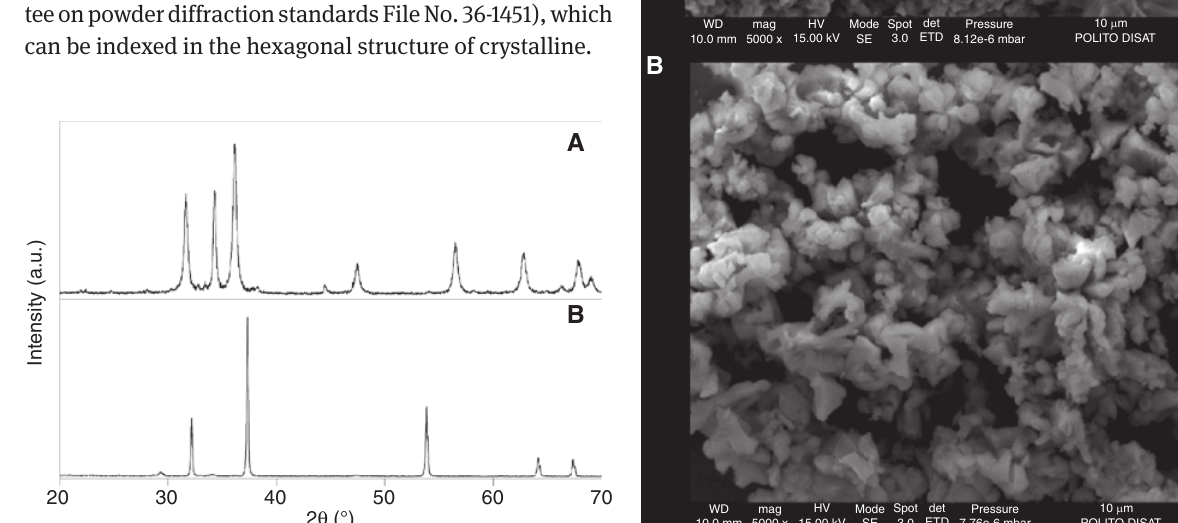
Figure 9: XRD pattern of ZnO (A) and CaO (B).